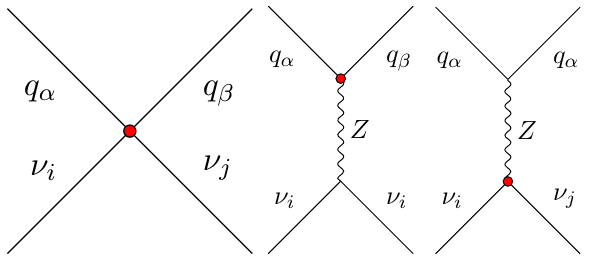
Fig. 1 Contributions of four-fermion operators (1), left-most diagram, and subleading ones involving Z -exchange, see text, to quark q pro- cesses into neutrinos, contained in the left-handed lepton doublet, with flavor indices α,β, i , j . Operators are denoted by a blob